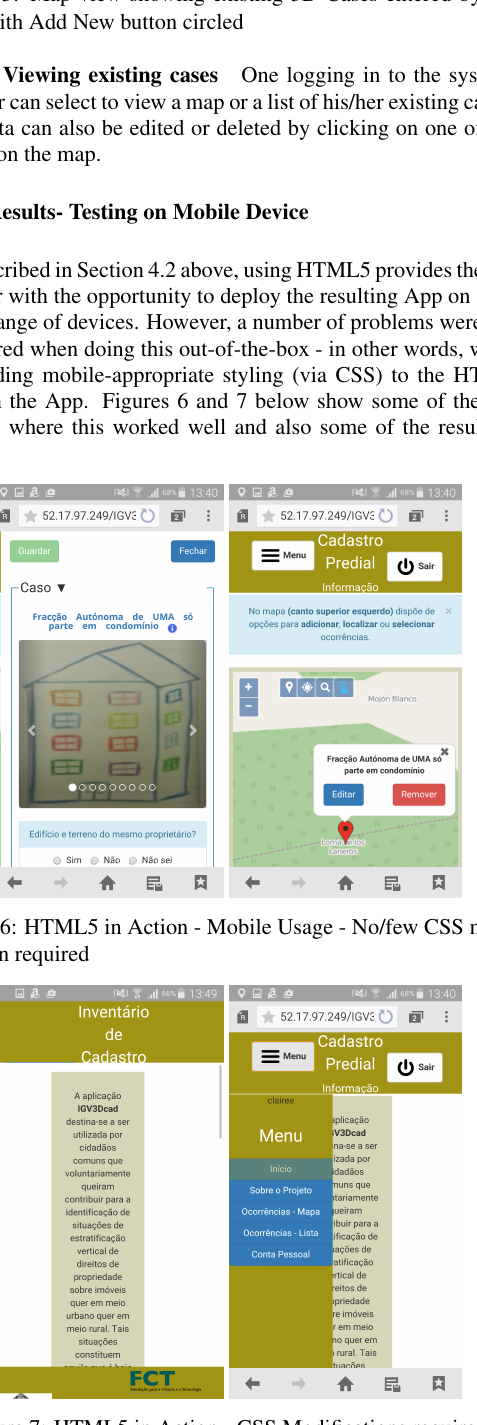
Figure 7: HTML5 in Action - CSS Modifications